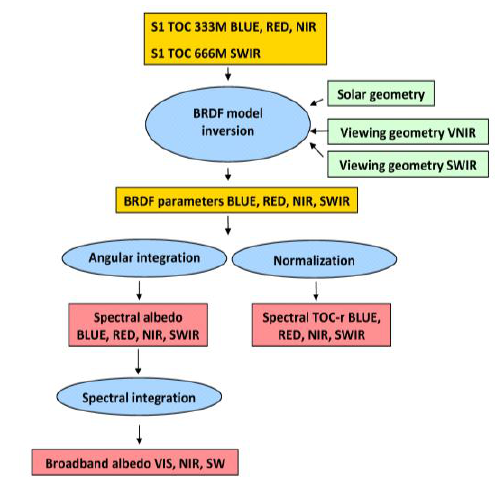
Figure 3: Flow chart of the surface albedo